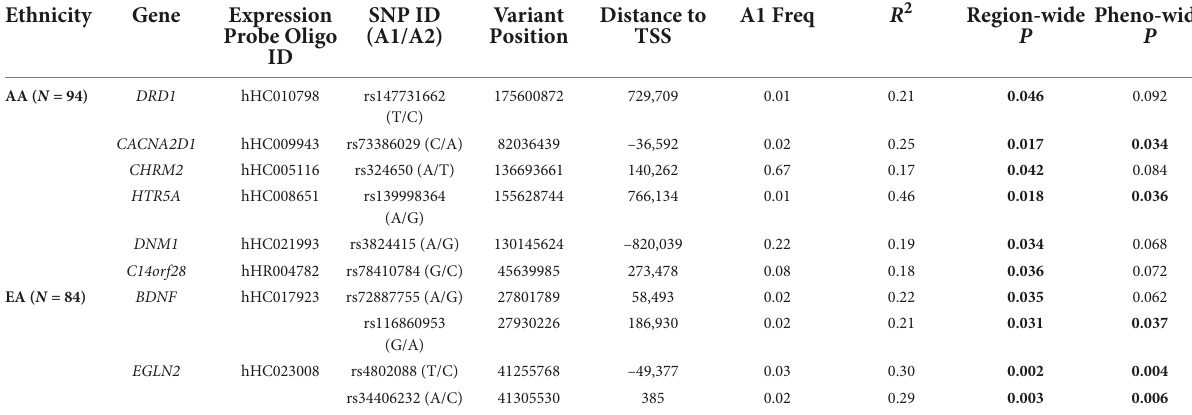
TABLE 3 Significant expression probe-SNP pairs with region- or phenotype (pheno)-wide cis associations in the AA and EA